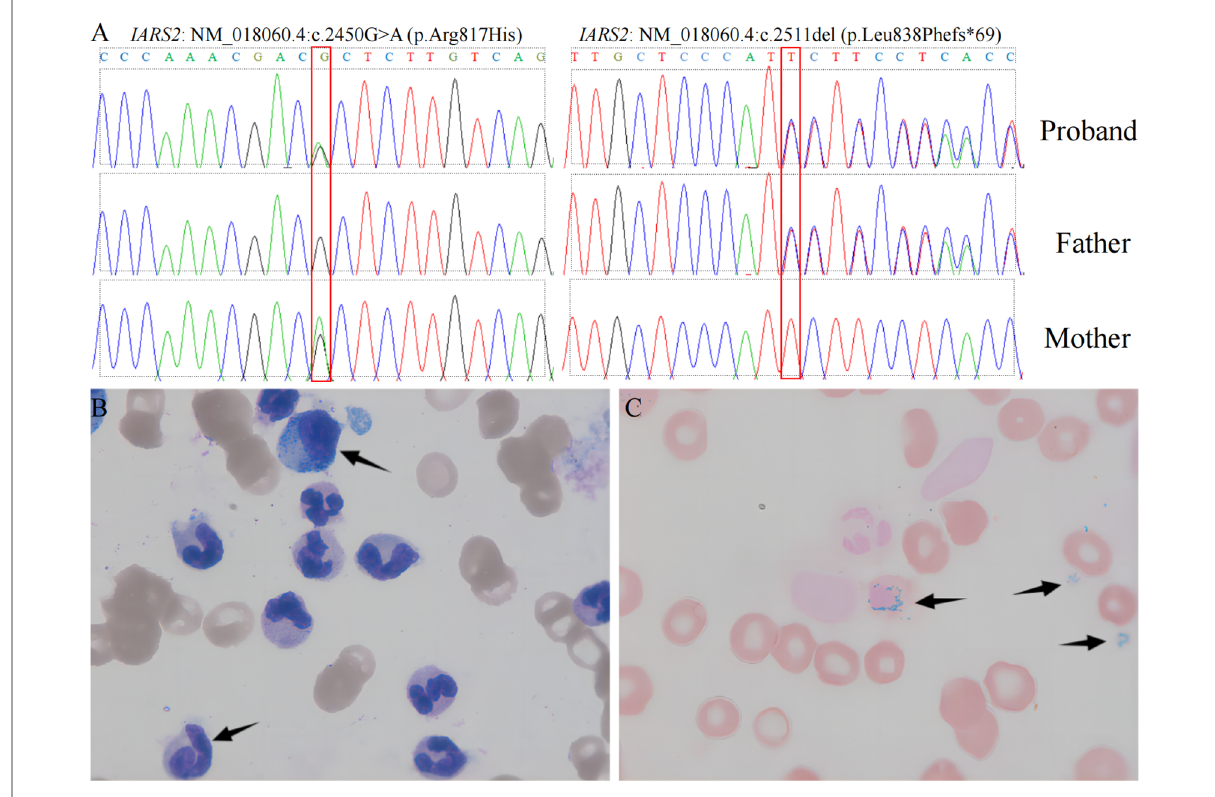
FIGURE 1 Genomic sequencing and bone marrow testing . Sequence electropherogram of part of exon of the IARS2 gene. left panel: IARS2: NM_018060.4: c.2450G>A ( p .Arg817His), right panel: IARS2: NM_018060.4:c.2511del ( p .Leu838Phefs*69). ( A ) Wright-Giemsa stained bone marrow aspirate smears: arrows (upper) denotes myelomonocytic cell, whereas arrow (lower) denote megakaryocytic cell. ( B ) Prussian-blue stained bone marrow: arrows indicate 3 of the numerous ringed sideroblasts